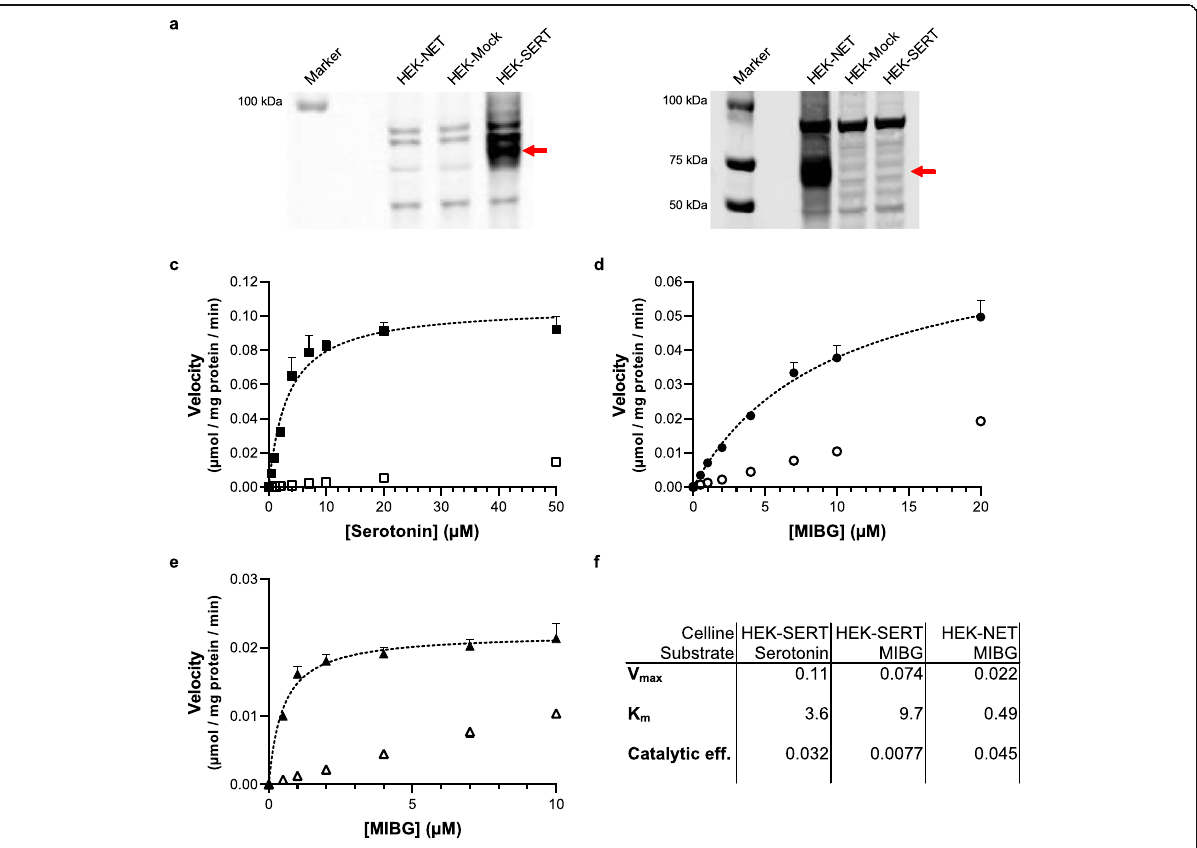
Fig. 2 Uptake of [ 3 H]serotonin and [ 125 I]MIBG in SERT- and NET-transfected HEK293 cells. a , b Results of Western blotting analysis on samples of transfected HEK cells. a Primary antibody against human SERT. b Primary antibody against human NET. c Uptake of [ 3 H]serotonin by HEK-SERT cells. d Uptake of [ 125 I]MIBG by HEK-SERT cells. e Uptake of [ 125 I]MIBG by HEK-NET cells. Closed symbols ( ■ , ● , ▲ ) represent baseline-corrected, transporter-specific uptake. Open symbols ( □ , ○ , Δ ) represent non-specific cellular uptake observed in HEK-Mock cells. Cells were incubated with substrate for 1 h. The Michaelis-Menten graph is depicted as a black dashed line. f The kinetic parameters from this analysis: V max in μ mol/mg